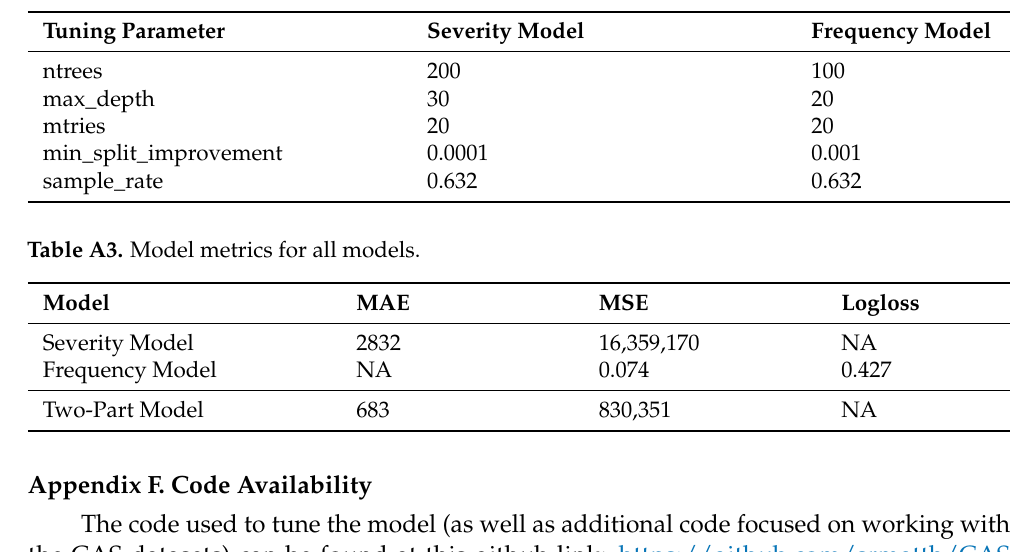
Table A2. Tuning parameters for the frequency and severity models.